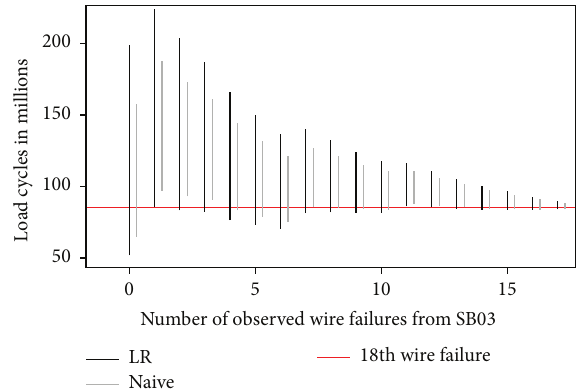
Figure 5: 90% prediction intervals based on the likelihood ratio and the naive method for the 18th wire failure of SB03 with different number of used previous failures from the same beam and all data from the other nine